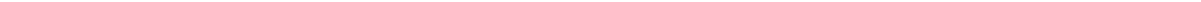
Fig. 4 Temozolomide mediated suppression of adult neurogenesis impairs ketamine antidepressant effect. a A timeline for the suppression of adult hippocampal neurogenesis by four cycles of temozolomide (TMZ). Each cycle includes single daily injections (25 mg/kg) on three consecutive days followed by a recovery period of four days. Ten days after the last cycle of TMZ treatment, mice were given four pulses of BrdU to label proliferating NPCs that were born after TMZ exposure. Eighteen days after BrdU pulses, mice were given Sal or Ket and then examined for anti-depressive like behavior in the FST 24 h later. b , c Sections from TMZ and vehicle (Veh) treated mice were immunostained with DCX (green), Ki67 (red) and DAPI (blue) for nuclei. DCX + cells that co-express Ki67 are denoted by arrows in the confocal images. Scale bar, 50 µ m. High power images of the area from the dash-line rectangle are shown in c , to highlight DCX+ cell morphology changes after TMZ treatment. Cells with dendrites (arrowheads) have migrated into the inner granular layer zone (GLZ), while cells without processes (asterisks) are still localized in the subgranular zone (SGZ). Scale bar, 10 µ m. d Quanti fi cation of total DCX + cell number in the DG ( n = 5 per group, p = 0.4073 by unpaired two-tailed t -test). e Percentage of DCX+ cells that express Ki67 in the DG ( n = 5 per group, ** p = 0.0027 by unpaired two-tailed t -test). f The proportion of DCX+ cells with or without dendrites was quanti fi ed in the DG ( n = 5 per group, *** p < 0.0001 by unpaired two-tailed t -test). g Quantitative analysis of BrdU pulse-chase for 18 days shows the number of newborn neurons (BrdU+/NeuN +/DCX − ) in the DG was signi fi cantly decreased (two-way ANOVA, Tukey post hoc, *** p < 0.0001 for saline vs ketamine treatment in vehicle mice, and Veh vs TMZ group with saline or ketamine treatment; * p = 0.0444 for saline vs ketamine treatment in TMZ mice). h FST shows ketamine ’ s antidepressant effect is fully abolished in TMZ-treated mice (2-way ANOVA with unweighted mean analysis, Tukey post hoc, *** p = 1.299E-6 for saline vs ketamine in vehicle treated mice and *** p = 1.192E-6 for ketamine-treated mice with vehicle vs TMZ). Circles in solid color denote the data points from female